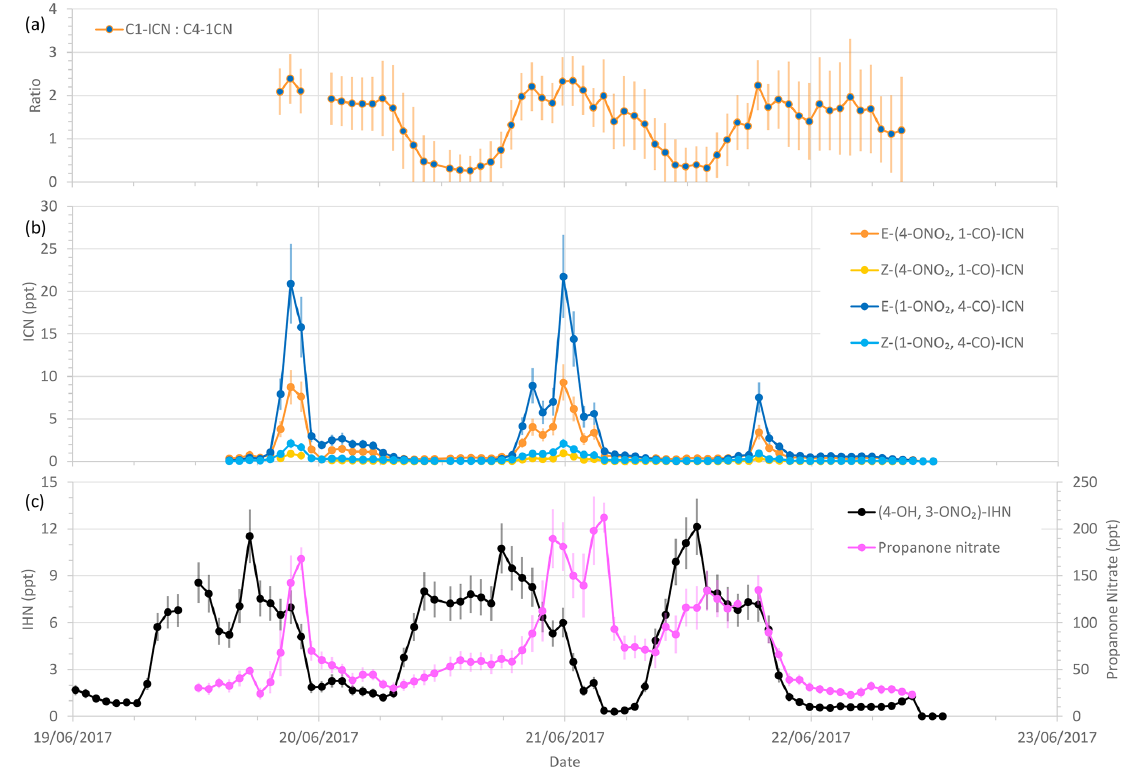
Figure 8. Measured δ -ICN mixing ratios and ratios of C1-ICN to C4-ICN, along with (4-OH, 3-ONO 2 )-IHN and propanone nitrate mixing ratios during the last 4d of the summer campaign. Error bars are the measurement uncertainties (see Sect. 3.3 for details). The vertical grid lines indicate midnight on each